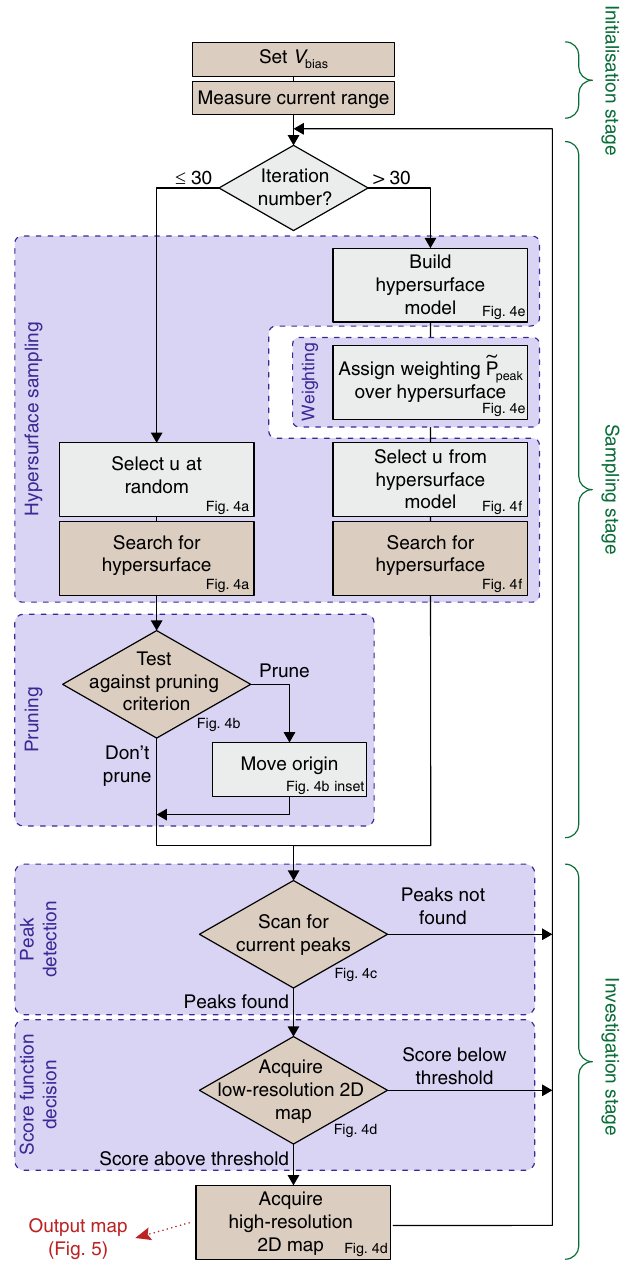
Fig. 3 Flow diagram of the algorithm. (See text and Fig. 4 for a full description.) Each step is annotated with the corresponding panel in Fig. 4. Steps that involve interaction with the device are shaded brown, and entirely computational steps are grey. In the ablation studies of Section “ Ablation study ” , the different modules that constitute the algorithm are studied in terms of their contribution to the algorithm ’ s performance; these modules are marked by the blue background regions. The steps belonging to the initialisation, sampling, and investigation steps are indicated on the formed. The investigation is carried out in the plane containing v ( u ) and de fi ned by varying the two plunger gate voltages V 3 and